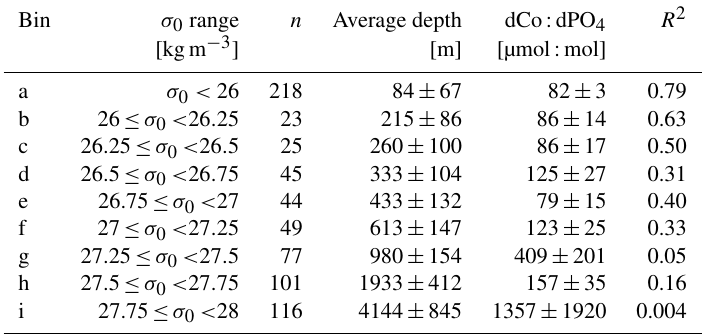
Table 2. Isopycnal analysis results. Samples were binned by potential density ( σ 0 ), and as σ 0 increased, the dCo:dPO 4 relationship became more decoupled, as shown by the decreasing R 2 value of the correlation. Error is given as standard deviations. Bin σ 0 range